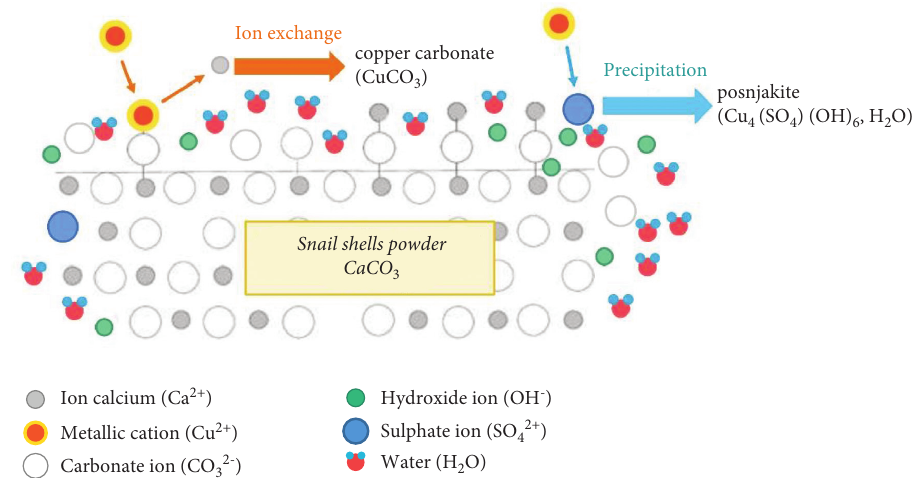
Figure 6: Schematic diagram of Cu(II) fixation by chemical precipitation and ion-exchange mechanism.